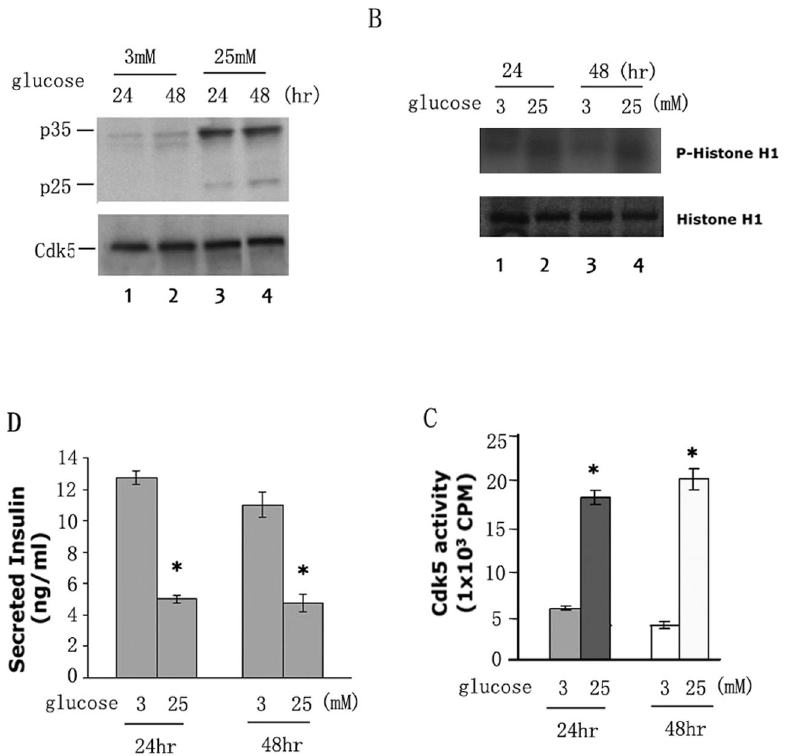
Figure 2. Chronic high glucose stimulation induces p25 expression in Min6 cells. A Endogenous p25 expression induced by high glucose (25 mM) (panel 1, lanes 3 and 4.) B Autoradiograph of phosphorylated histone H1 in the glucose induced Min6 cells (panel 1, lanes 2 and 4). The same cell lysates were used for the kinase assay using Cdk5 immunoprecipitates. C Quantification of Cdk5 activities in the glucose induced Min6 cells. D Insulin secretion assay. The insulin secretion was significantly inhibited in the high chronic glucose treated cells compared to the low glucose treated cells (* P , 0.01). Data represent mean 6 SE of three experiments.